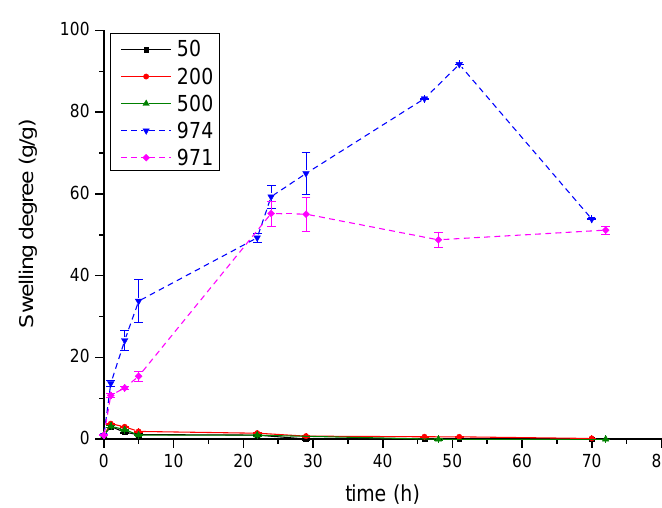
Figure 4. Swelling degree of pure polymers in simulated saliva.